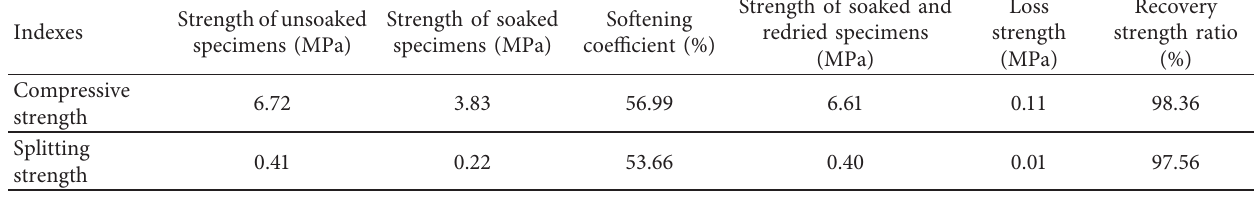
Table 5: Water stability performance of SSGM.